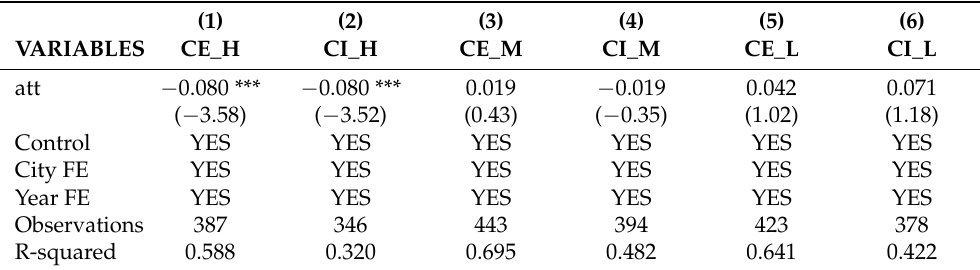
Table 12. Heterogeneity of industrial agglomeration